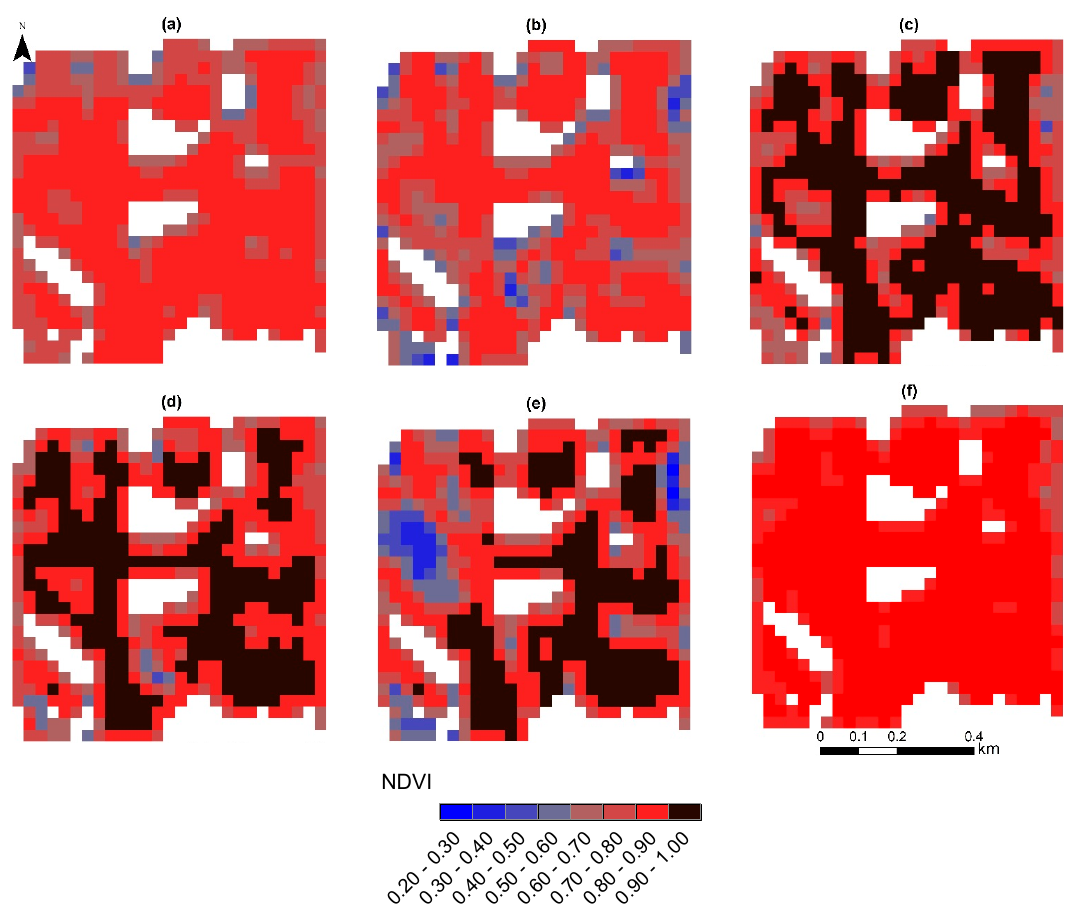
Figure 6. NDVI maps for the month of July: 2016 ( a ), 2017 ( b ), 2018 ( c ), 2019 ( d ), 2020 ( e ), and 2021 ( f ). In the present study, the spatial patterns of NDVI changes in the months of July for area percentages of each class of NDVI changes are presented in Table 3. From 2016 to 2017, the NDVI values decreased and increased to 73.86 and 26.14% of the total area, re- spectively (Table 3). As can be seen from Figure 7a, the biggest reduction in NDVI values occurred in the southern part in comparison with the eastern part of the studied area. By contrast, from 2017 to 2018, the NDVI values decreased and increased in 1.89 and 98.1% of the studied area, respectively (Table 3). Figure 7b shows that the NDVI values from 2017 to 2018 mostly increased in all parts of the studied area, especially in the southern part. The NDVI values from 2018 to 2019 decreased and increased by 78.11 and 21.89% of the total area, respectively (Table 3). The NDVI values mostly changed in the southern part of the studied area (Figure 7c). Figure 7d,e shows that the biggest changes from 2019 to 2020 and from 2020 to 2021 mostly occurred in the northwestern part of the studied area. In addition, small changes can be observed in other parts of the studied area from 2019 to 2020 and from 2020 to 2021 (Figure 7d,e).